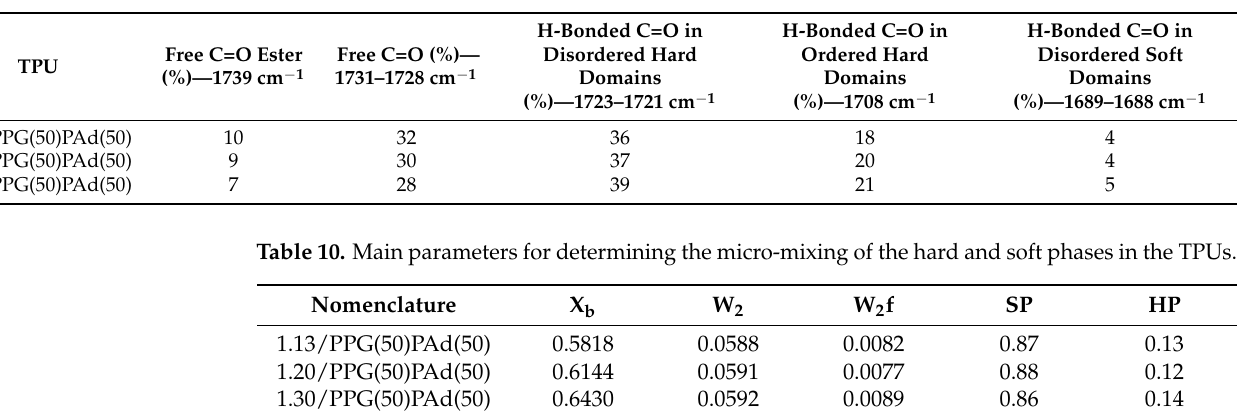
Table 9. Percentages of C=O species of the TPUs synthesized with different NCO/OH ratios. Curve fitting of the carbonyl region of the ATR-IR spectra.